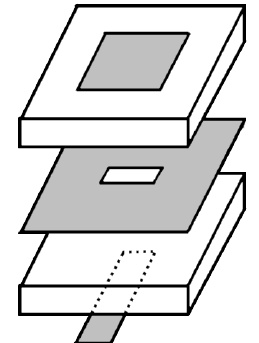
Figure 4. Aperture coupling feed